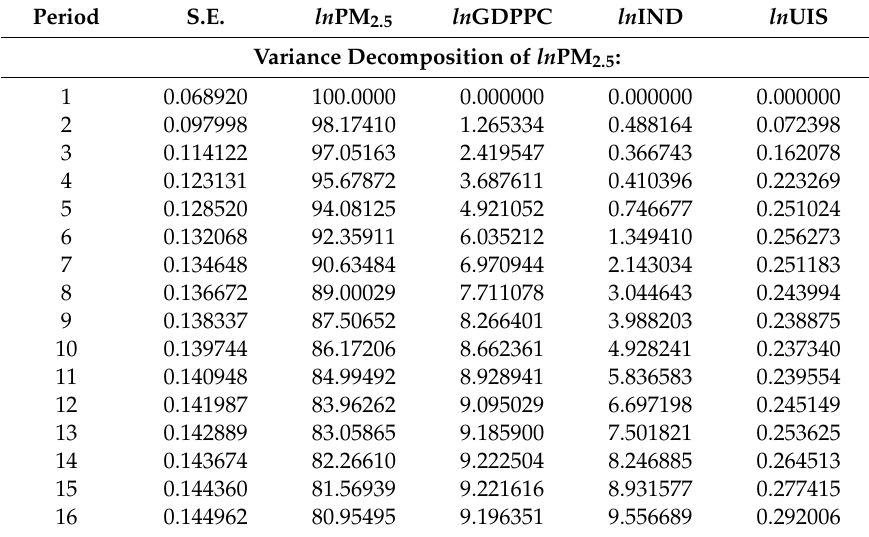
Table 6. Variance decomposition analysis results of pm 2.5 concentrations in the panel.